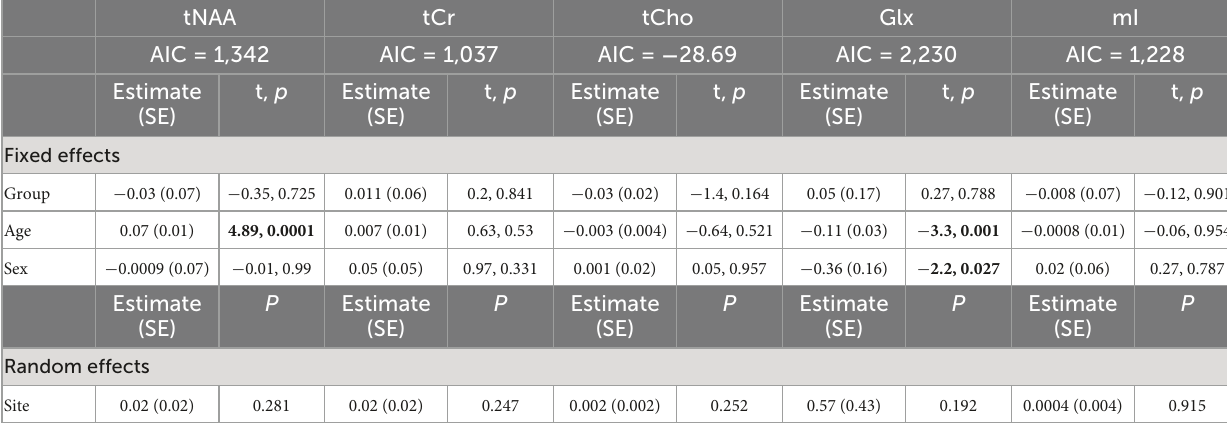
TABLE 8 Details of the linear mixed-effects model with metabolites of interest (tNAA, tCr, tCho, Glx, and mI) harmonized by vendor using ComBat as the dependent